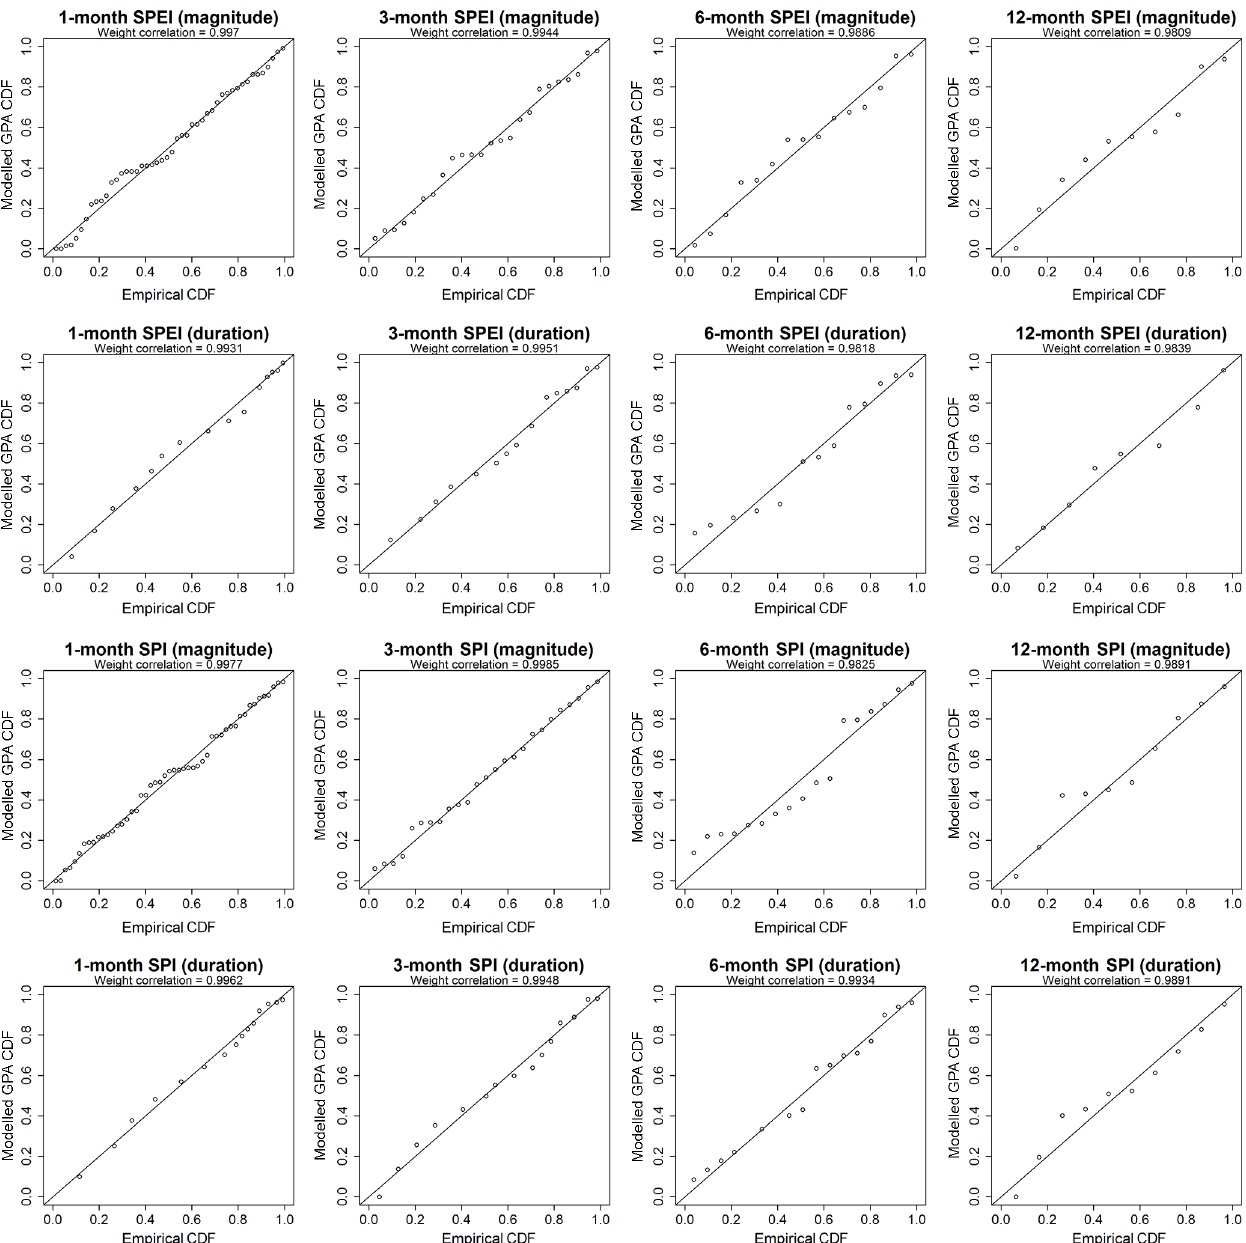
Figure 5. Example of probability–probability (P–P) plots for the series of 1-, 3-, 6-, and 12-month SPEI and SPI drought duration and drought magnitude obtained by means of the 80th percentile used as a threshold to derive the peak-over-threshold